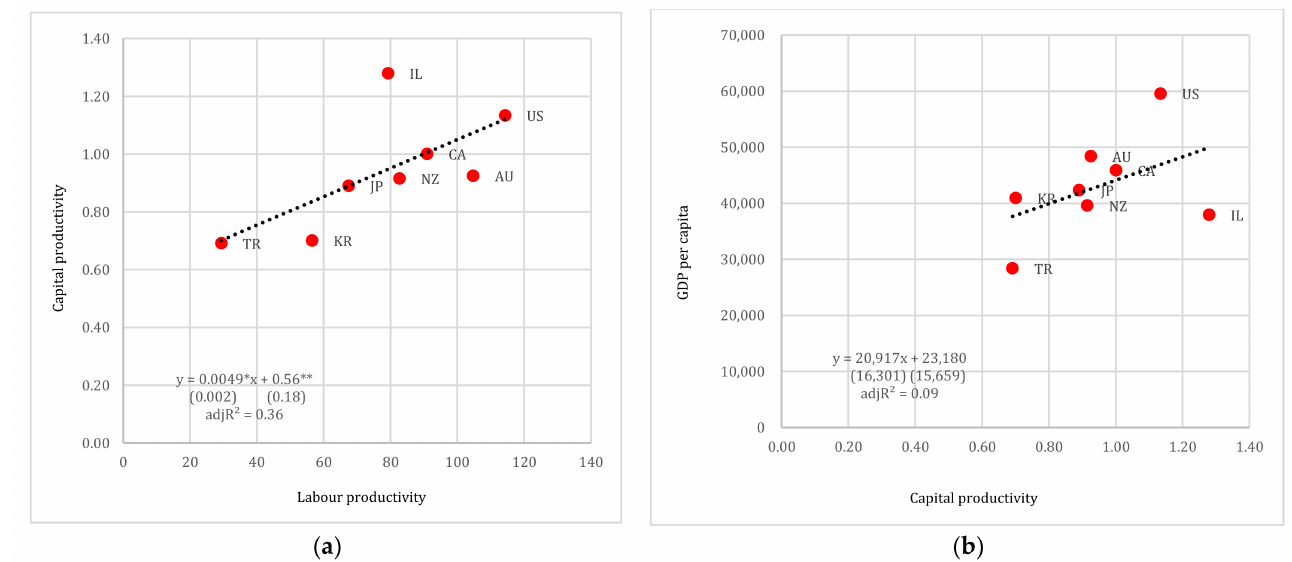
Figure 9. ( a ) Labour productivity vs. capital productivity and ( b ) capital productivity vs. GDP per capita (in USD pps), rest of the world. Note: Standard errors reported in parentheses. *, ** denote 10% and 5% levels of statistical significance,